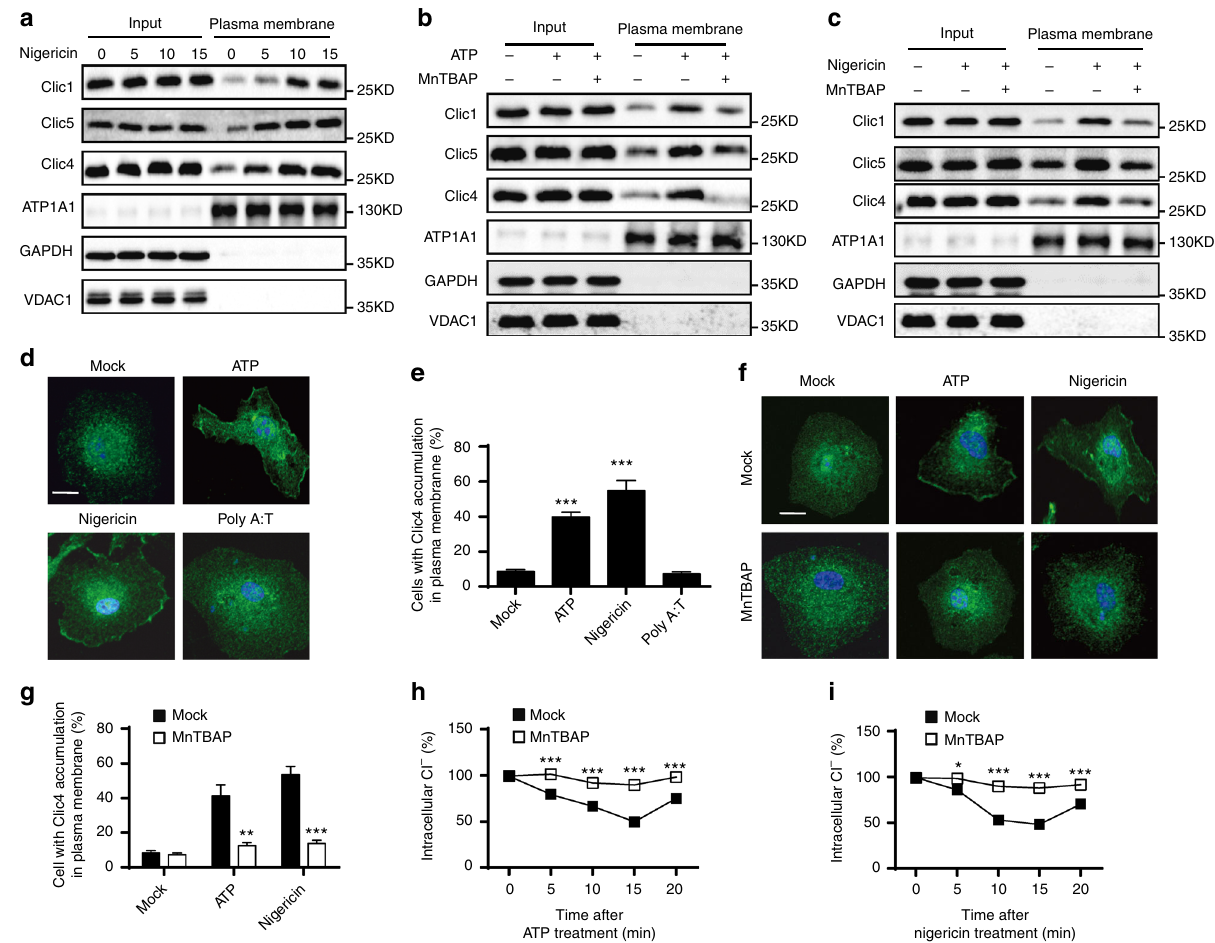
Fig. 7 ROS promotes NLRP3 agonists-induced Clics translocation and chloride ef fl ux. a Immunoblot analysis of the indicated proteins in total lysates (Input) or isolated plasma membrane of LPS-primed BMDMs stimulated with nigericin at different time points. b , c Immunoblot analysis of the indicated proteins in total lysates (Input) or isolated plasma membrane of LPS-primed BMDMs stimulated with ATP b or nigericin c for 15 min with or without the presence of MnTBAP (10 μ M). d , e Confocal microscopy analysis d or quali fi cation of cells with membrane translocation of Clic4 e in BMDMs stimulated with ATP, nigericin or poly A:T for 15 min. Scale bar , 10 μ m. f , g Confocal microscopy analysis f or quali fi cation of cells with membrane translocation of Clic4 g in BMDMs stimulated with ATP or nigericin for 15 min with or without the presence of MnTBAP (10 μ M). Scale bar , 10 μ m. h , i Quali fi cation of the decrease of intracellular chloride of BMDMs stimulated with ATP h or nigericin i with or without the presence of MnTBAP (10 μ M). Data are from three independent experiments with biological duplicates in each ( h , i ; mean ± SEM of n = 6) or are representative of three independent experiments a – d , f